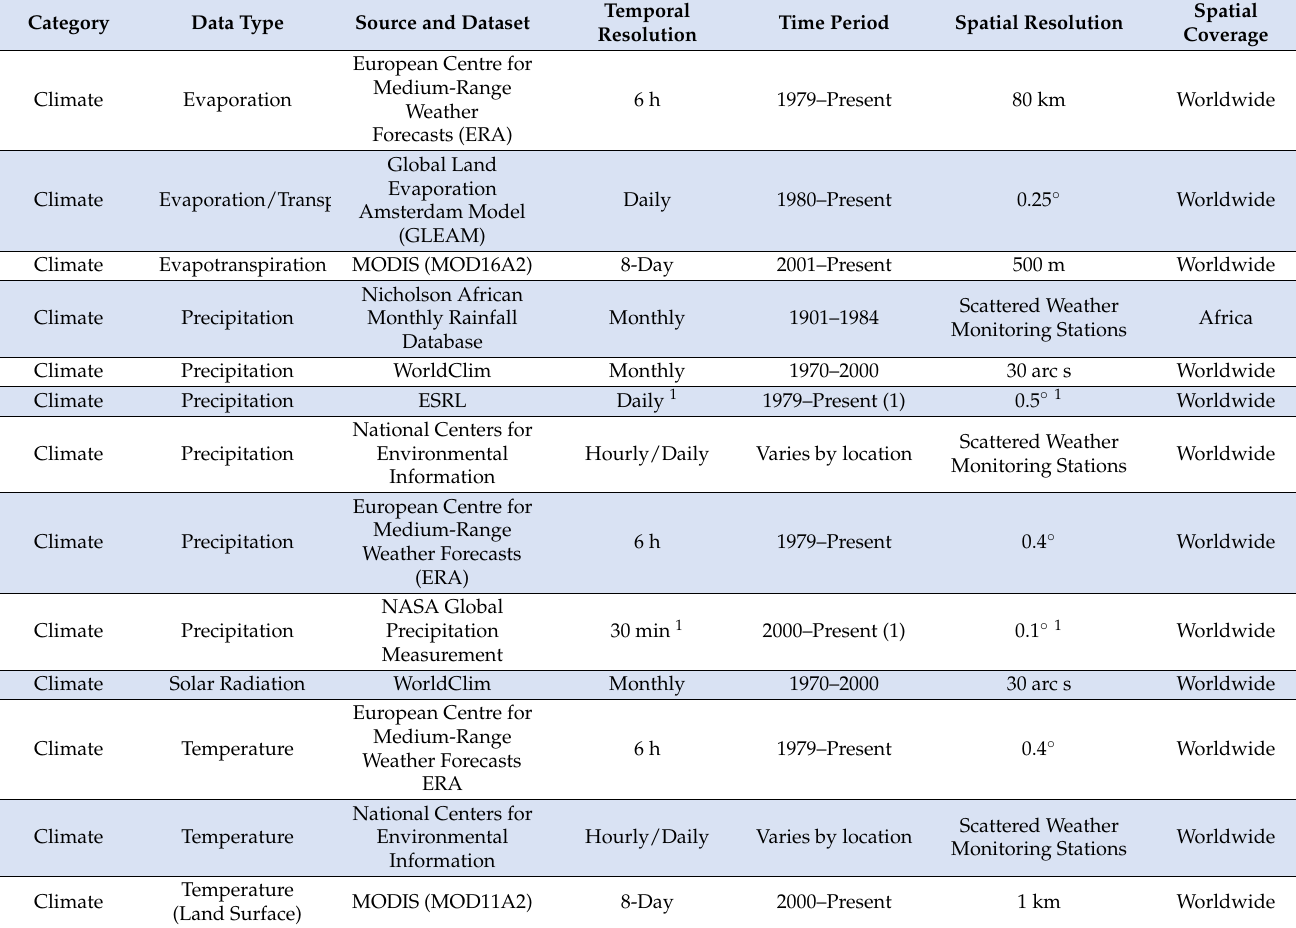
Table A1. List of data sources currently databased in the Large Basin Data Portal as of 30 March 2023. The list shows the temporal and spatial resolution of the datasets, along with time period and spatial